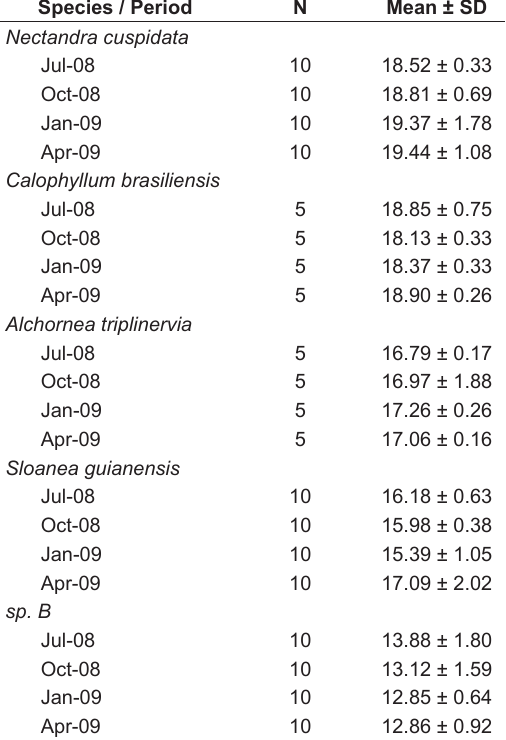
Table 1. Number of sub-samples (N) and mean ± standard deviation (Mean ± SD) of caloric content (KJ.g –1 ) of each species and months from CES riparian areas.